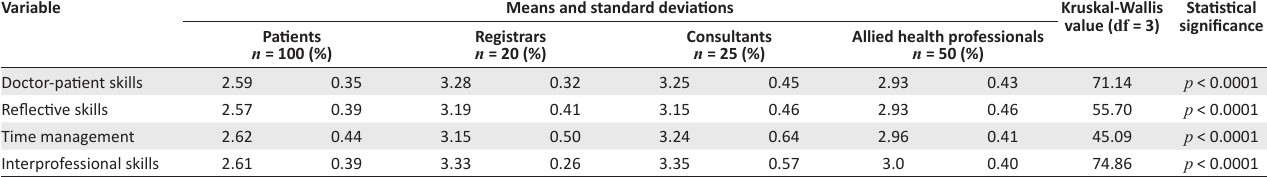
TABLE 2: Comparisons among the four participant groups for the scaled scores on the subscales of the Professionalism Mini-Evaluation Exercise Questionnaire. Variable Means and standard